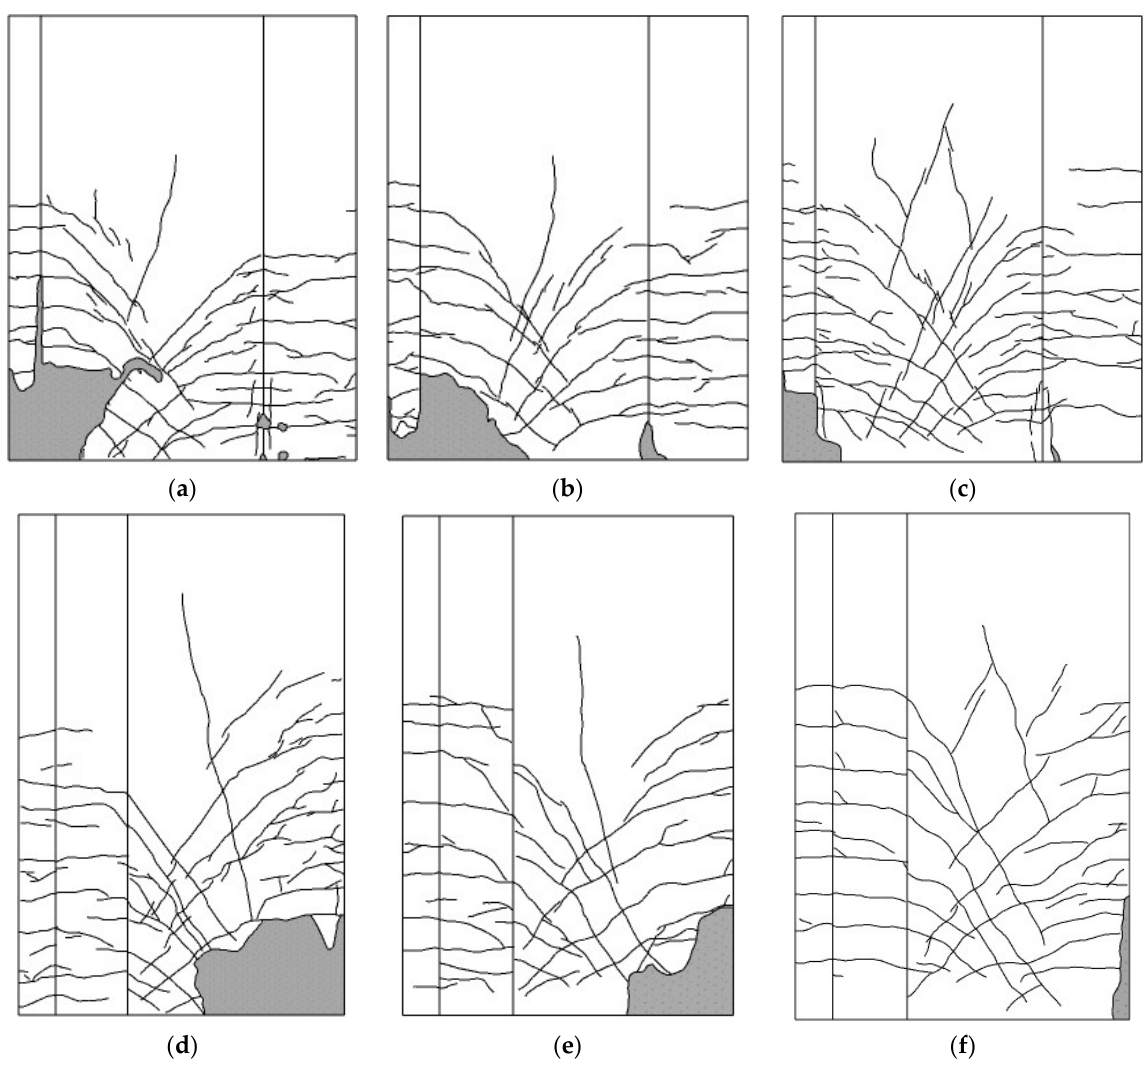
Figure 6. Schematic of the failure of specimens at the limit state: ( a ) crack development view of the front and side of LSW; ( b ) crack development view of the front and side of LAPC-1; ( c ) crack development view of the front and side of LAPC-2; ( d ) crack development on the back of LSW; ( e ) crack development on the back of LAPC-1; and ( f ) crack development on the back of LAPC-2.